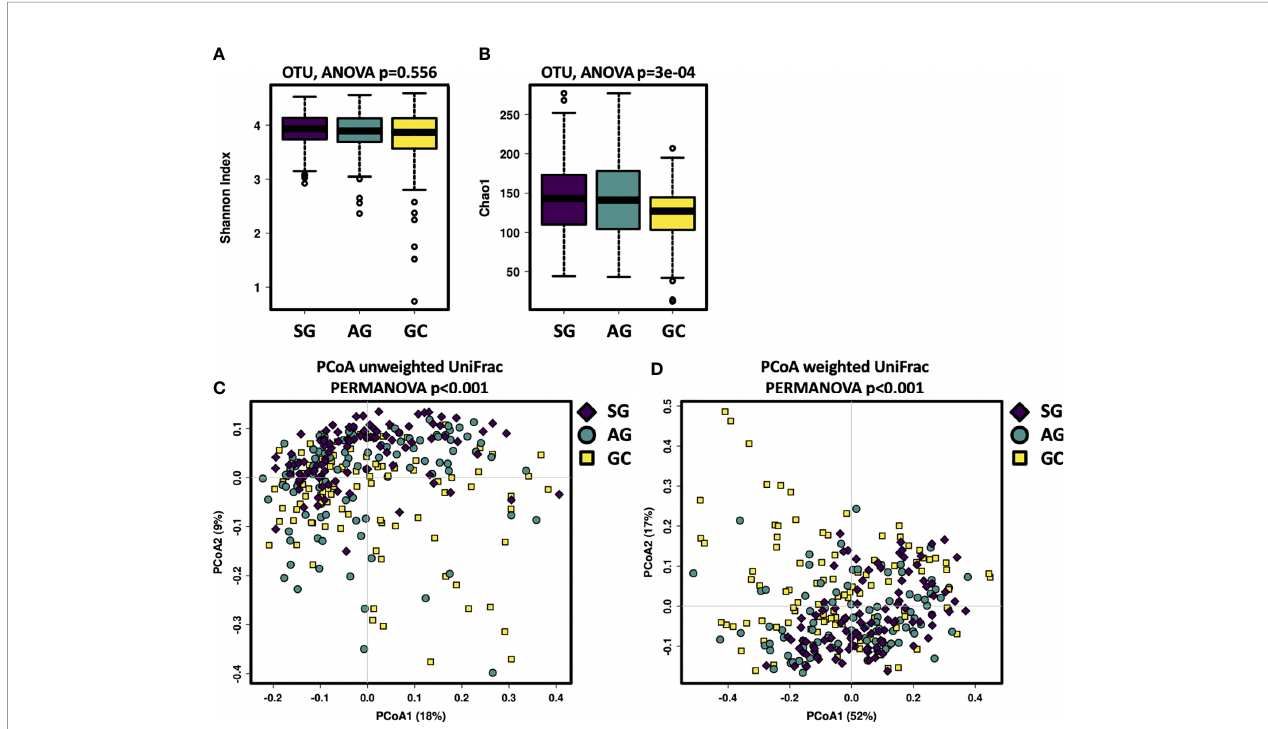
FIGURE 1 | The salivary microbiota biodiversity in patients with malignant and non-malignant gastric lesions. The alpha diversity of salivary microbiota was measured at the ASV level by using (A) Shannon index, (B) Chao1. Signi fi cance was determined by using Kruskal – Wallis rank sum test, and Wilcoxon rank-sum tests for each of the two groups. PCoA based on (C) unweighted UniFrac distance matrix, and (D) weighted UniFrac distance matrix revealed distinct clustering of GC